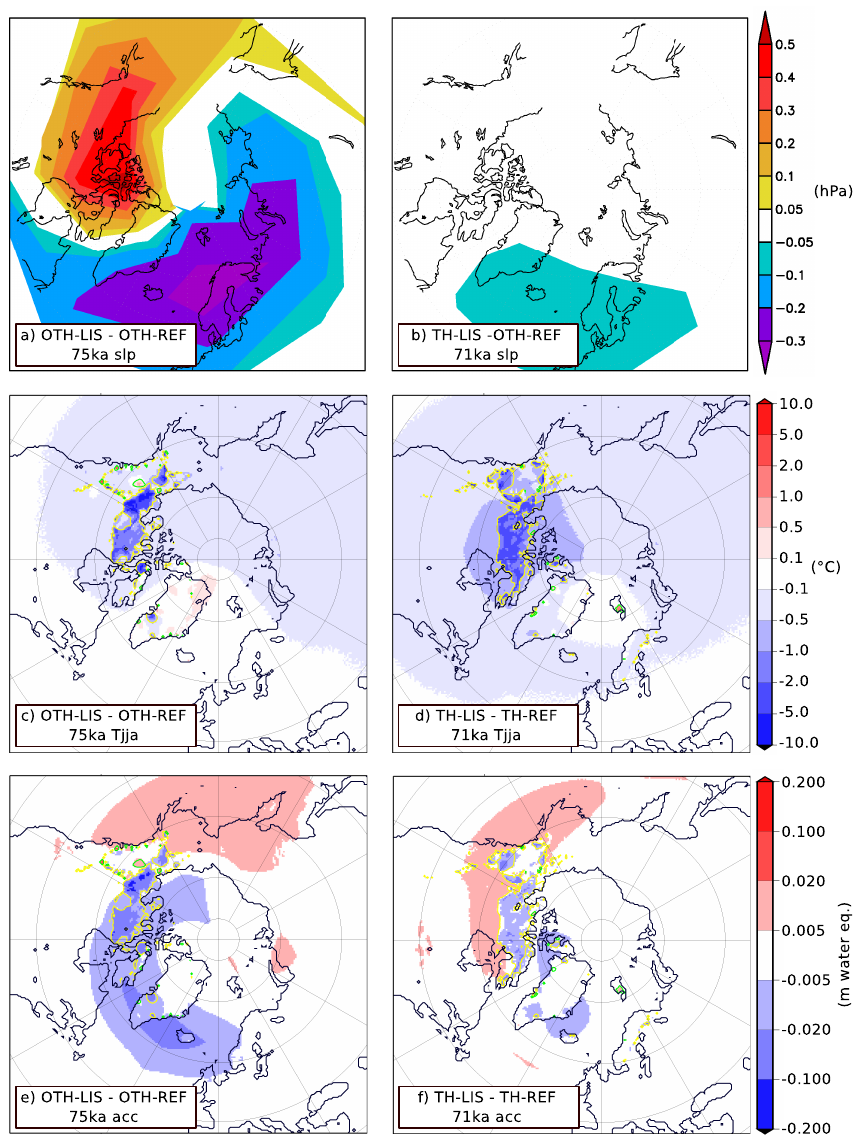
Fig. 9. Sea-level pressure differences (in hPa) between OTH-LIS and OTH-REF at 75ka (a) and between TH-LIS and TH-REF at 71ka (b) . Summer temperature difference between OTH-LIS and OTH-REF at 75ka (c) ; and TH-LIS and TH-REF at 71ka (d) ; accumulation difference between OTH-LIS and OTH-REF at 75ka (e) ; and TH-LIS and TH-REF at 71ka (f)